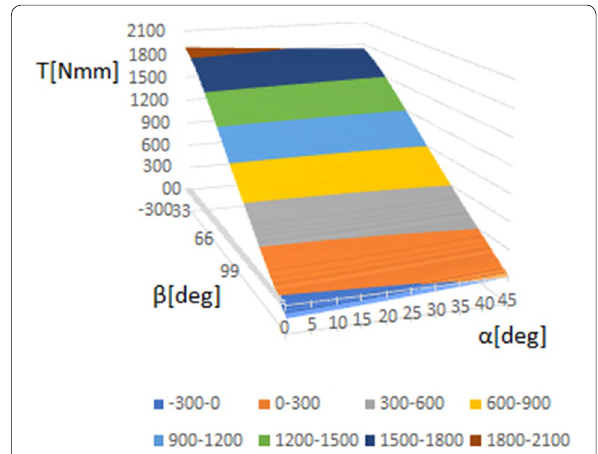
Fig. 16 Simulation results of rising